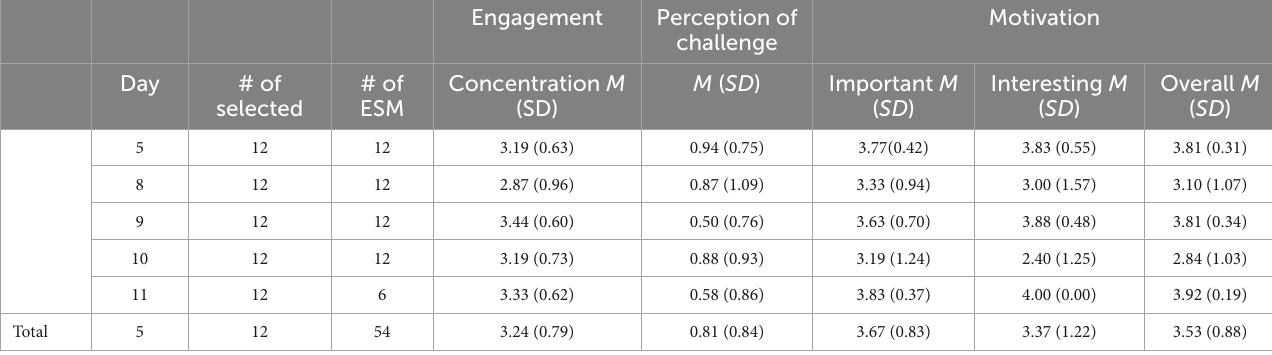
TABLE 4 ESRF: Selected students’ engagement, perceptions of challenge, and motivation during the complex task across days.